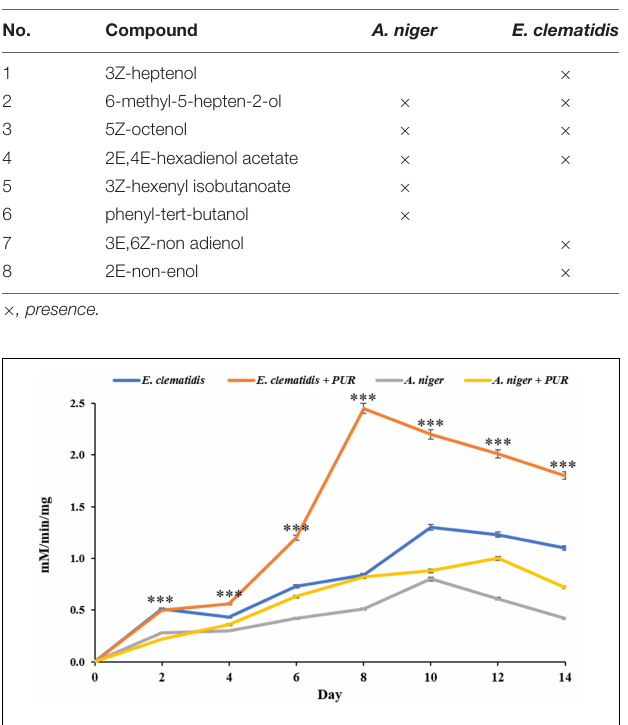
FIGURE 8 | Esterase activity of E. clematidis and A. niger in the presence and absence of Impranil as the sole carbon source after 2-week inoculation. ∗∗∗ Above the points indicates a significant difference ( p < 0.001) (ANOVA, followed by Dunnett’s